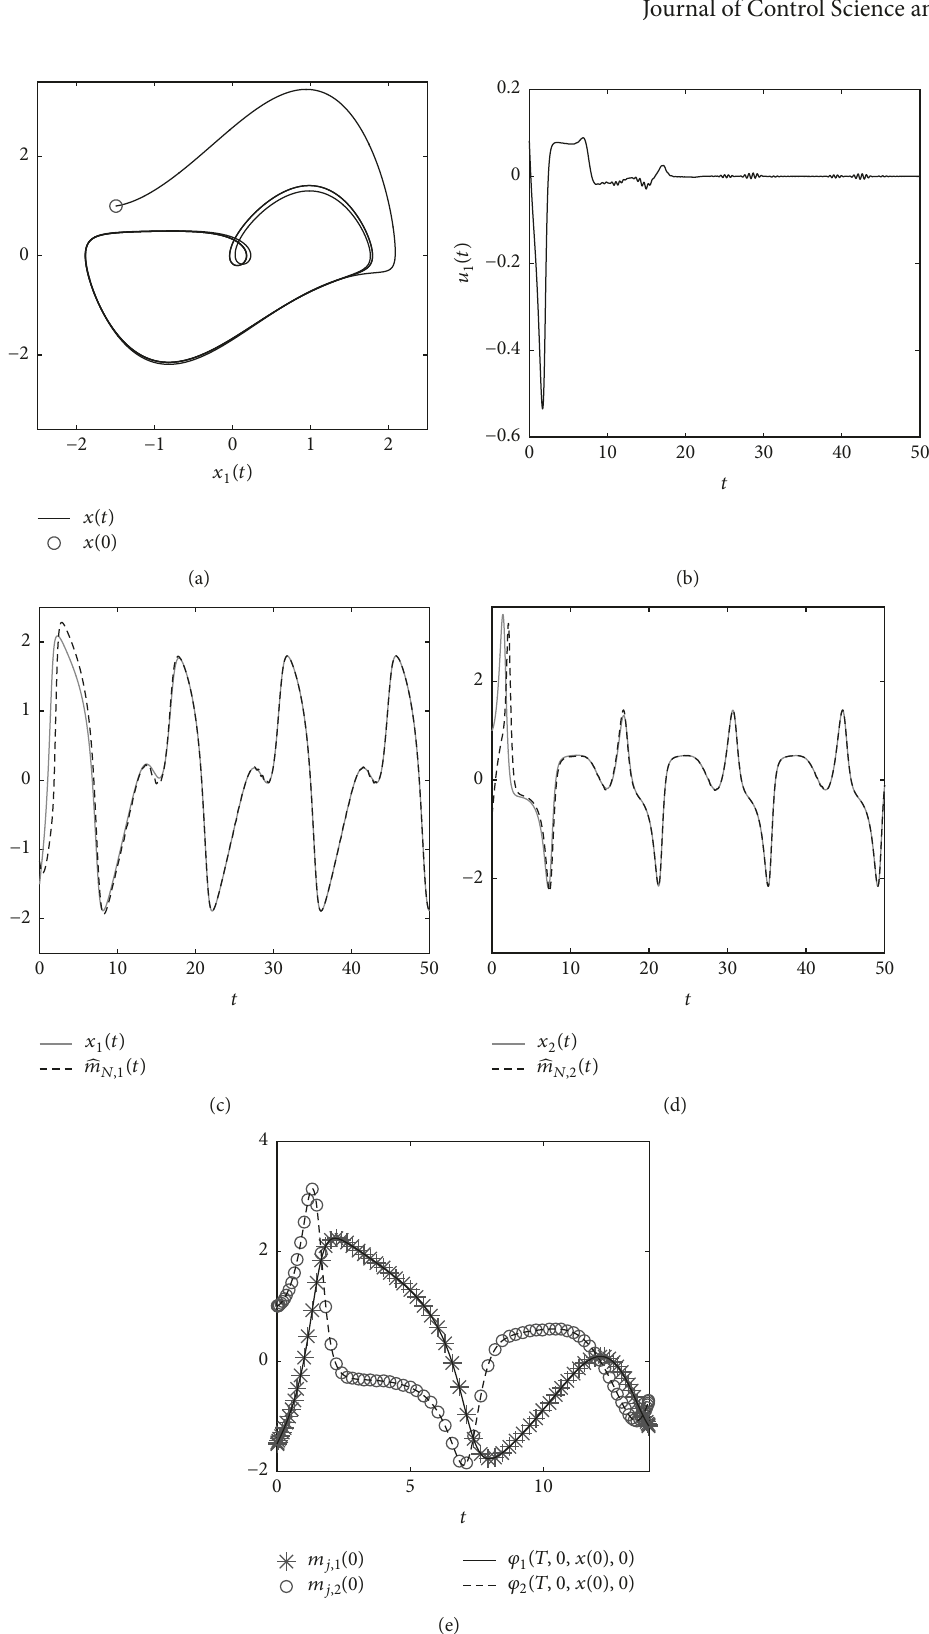
Figure 10: aPBC applied with 𝑁 = 82 , 𝑘 = 0.25 , and 𝑘 𝑜 = 10 . (a) Trajectory in state space; (b) time-series of the control signal; ((c) and (d)) time-series of the actual and predicted state variables; (e) time-series of 𝜑(𝑇,0, 𝑥(0),0) and the initial value of the predicted states 𝑚 𝑗 (0)